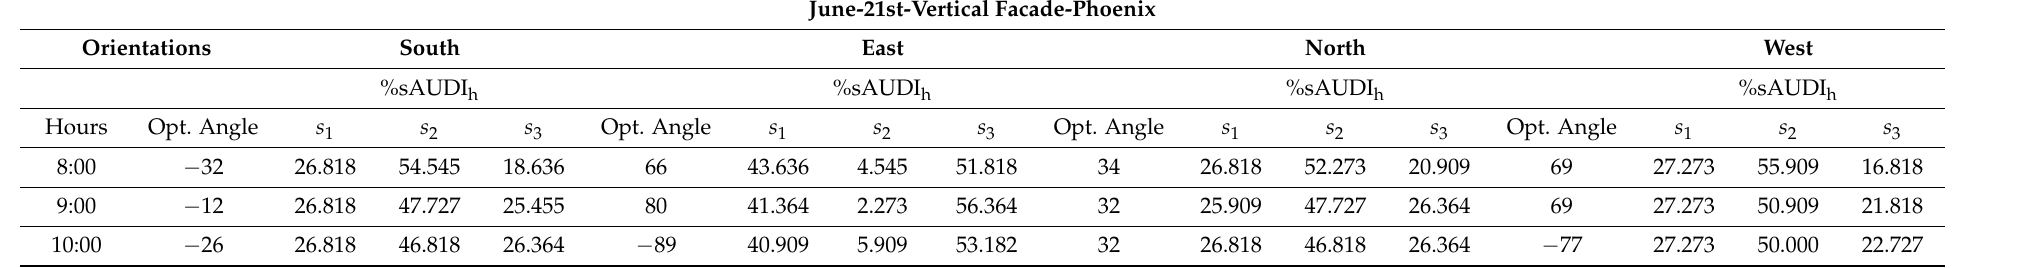
Table 3. Hourly optimum angles and the associated sAUDI h for three different human activities of s 1 , s 2 , and s 3 and four facade orientations calculated for 21 June-Phoenix-Vertical